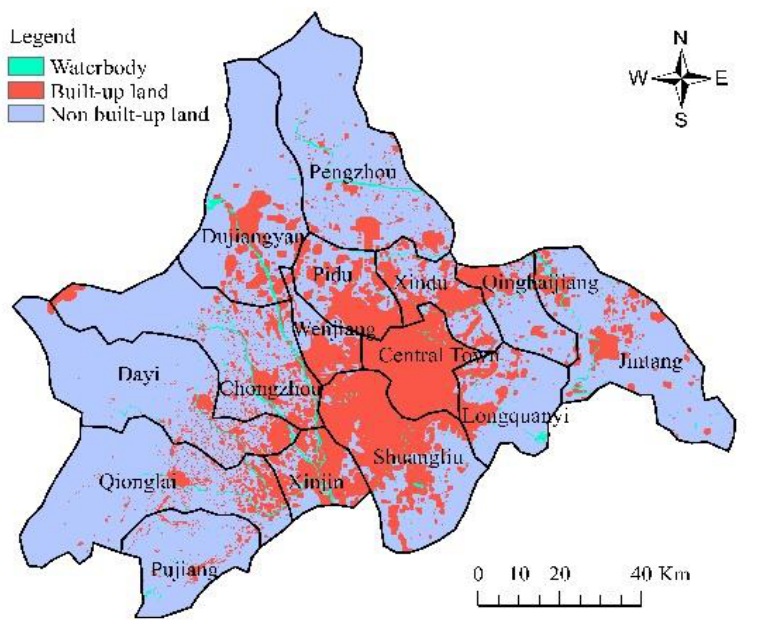
Figure 9. Simulation result of land use in 2035.